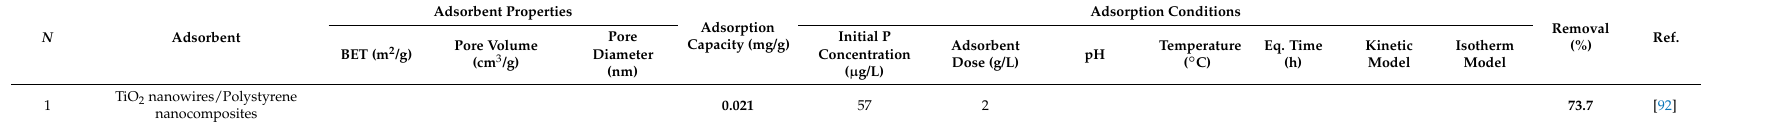
Table 11. Nanofibrous adsorbent properties and adsorption conditions for the removal of Chlordane.